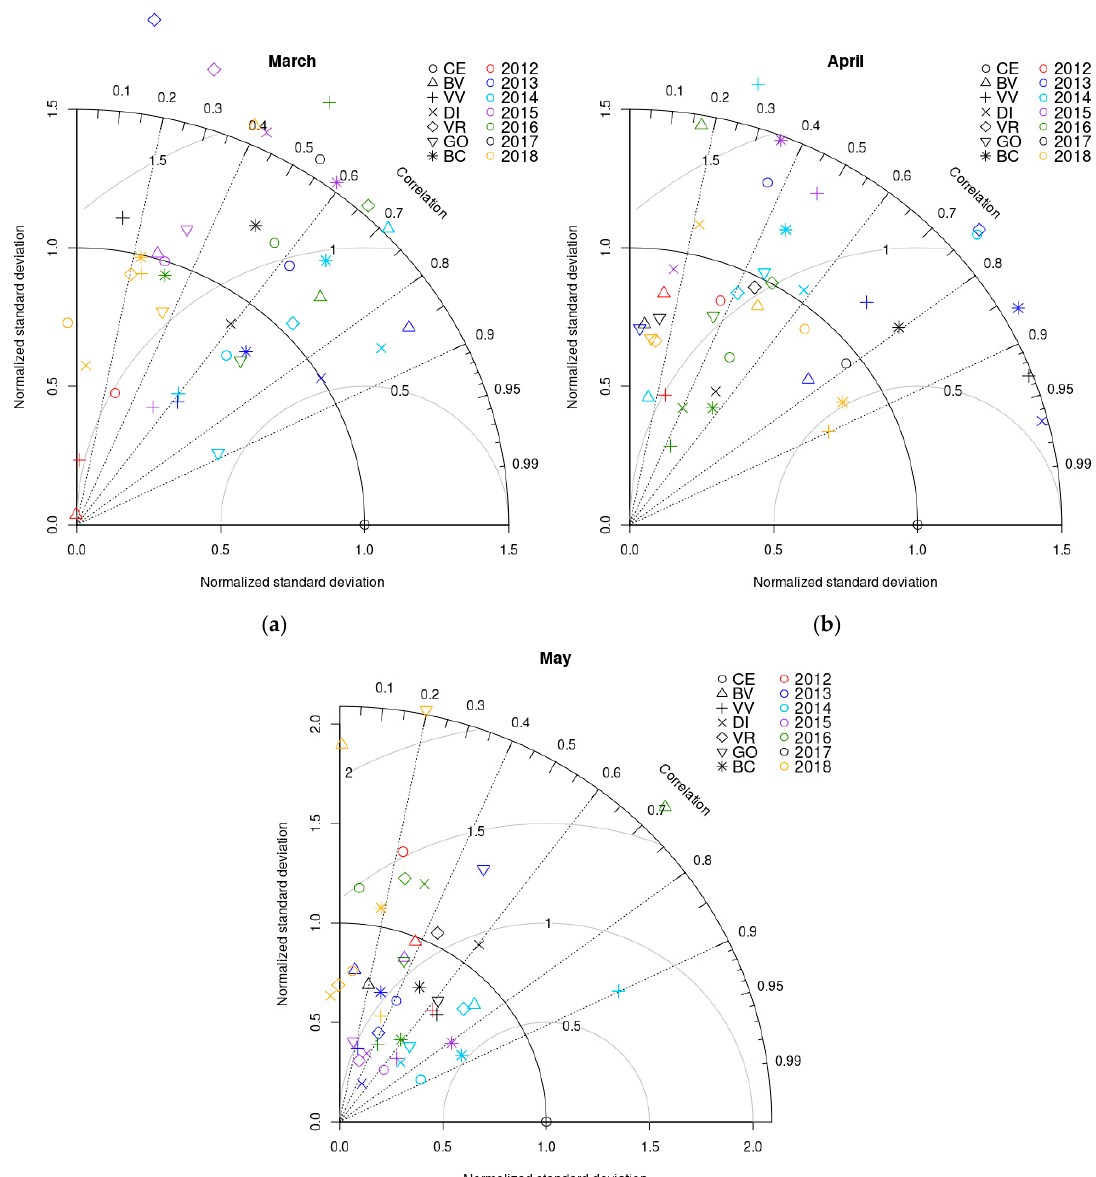
Figure 5. Daily precipitation RMSE (mm) and BIAS (mm) for selected locations during MAM 2012–2018.